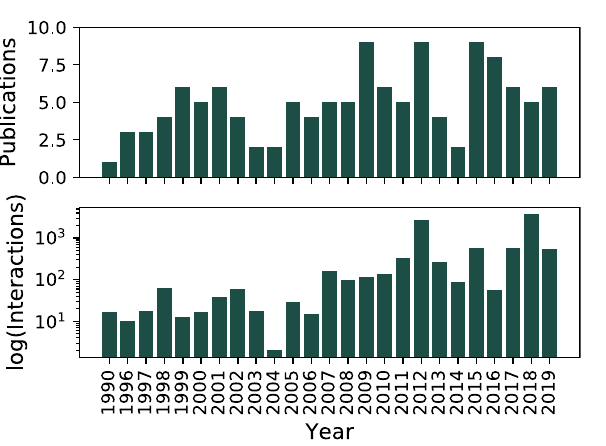
Figure 2. Interactions curated from literature for Streptomyces coelicolor A3(2). ( a ) Number of publications per year and ( b ) Number of interactions reported per